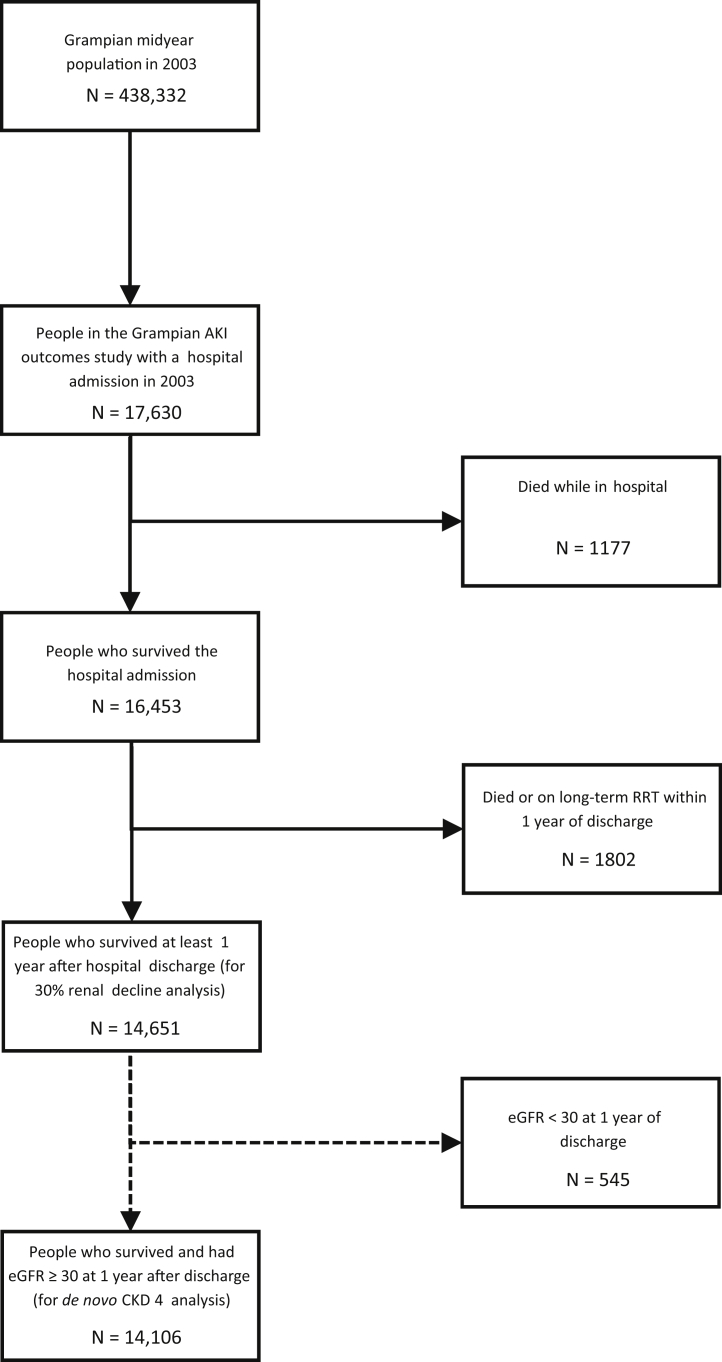
Flow diagram showing derivation of the cohort from the Grampian population. AKI, acute kidney injury; RRT, renal replacement therapy.